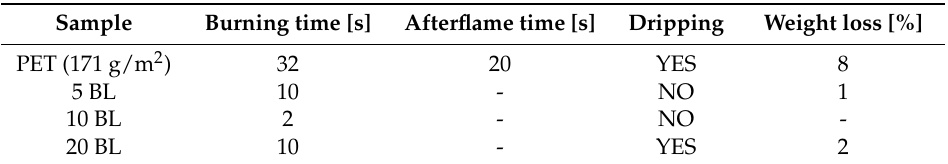
Table 8. Combustion data of untreated and LbL-treated PET by flame spread tests according to the ASTM D6413 standard